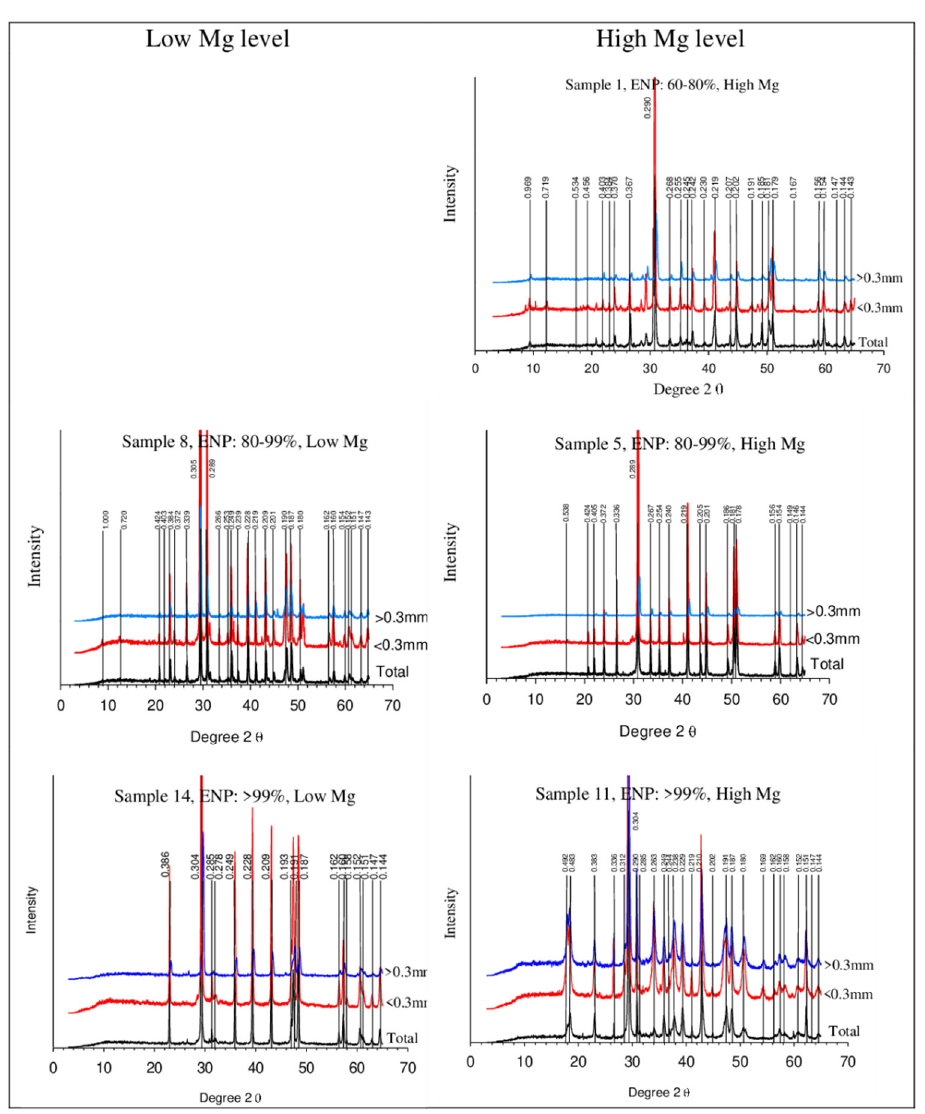
Figure 2. X-ray diffraction patterns from representative liming products (in three fractions) were separated into three groups of efficiency neutralizing power (ENP) and two Mg levels (low and